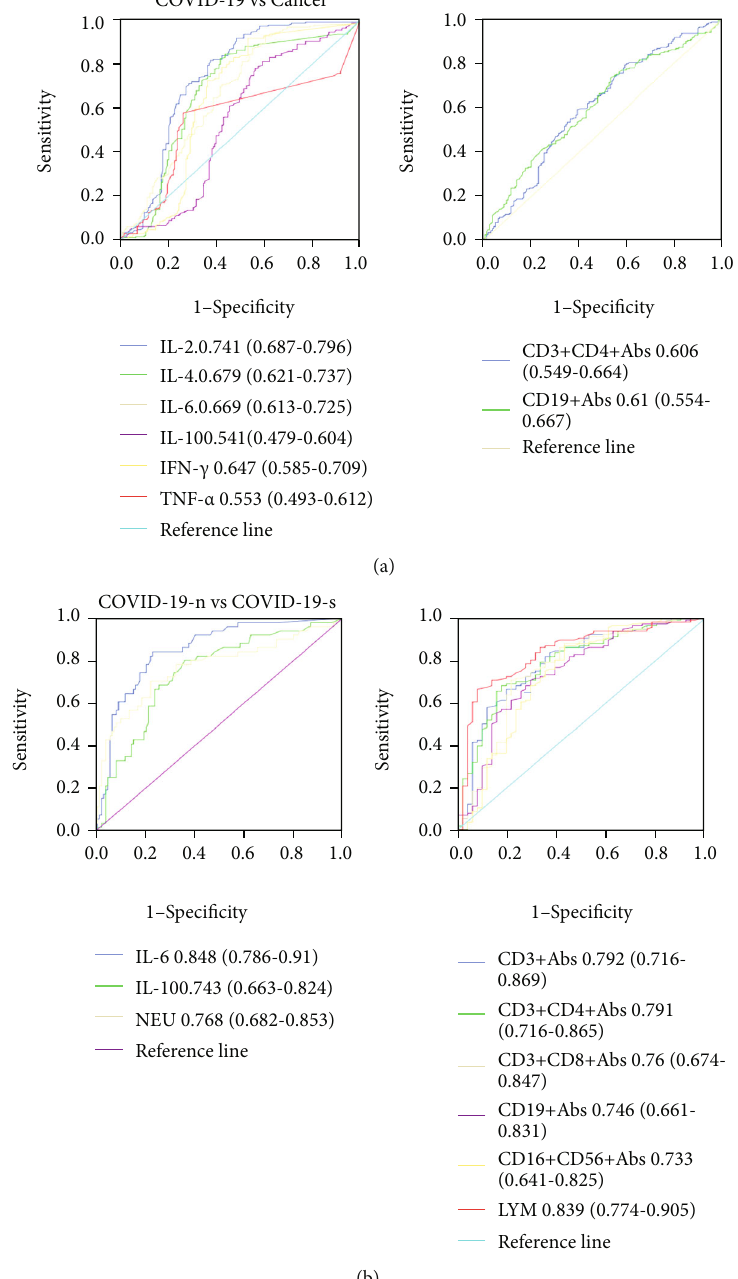
Figure 6: ROC curve analysis of immune cells and cytokines. (a) Between COVID-19 and cancer patients and (b) between severe and nonsevere COVID-19